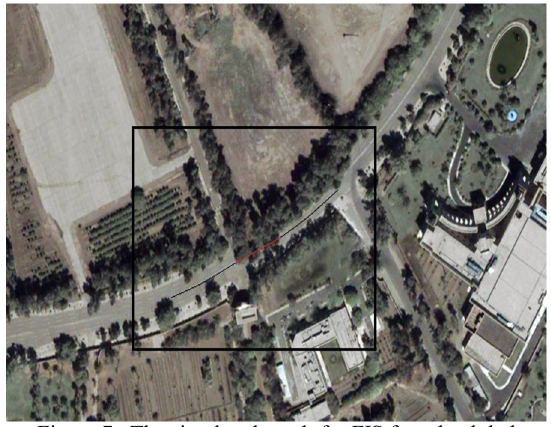
Figure 7. The simulated result for FIS from baghdad In figure 6 we have tree class across the road network. The FIS can detect that the link hypothesis is